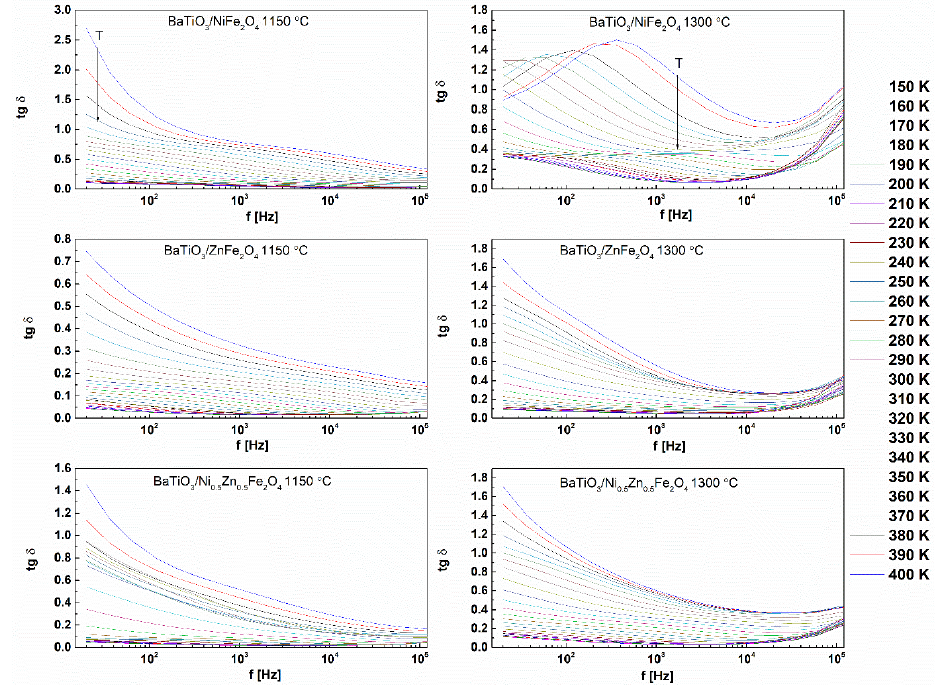
Figure 9. Tangent loss as a function of the frequency of the sintered samples and its temperature dependence.